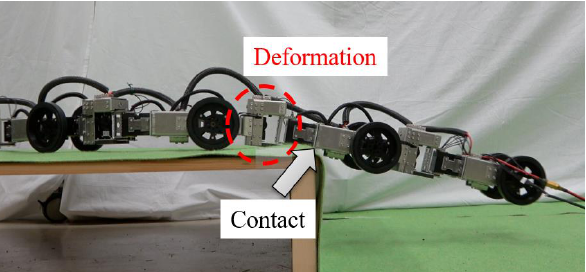
Figure 9. Contact between the robot and the step caused by deformation of the prismatic